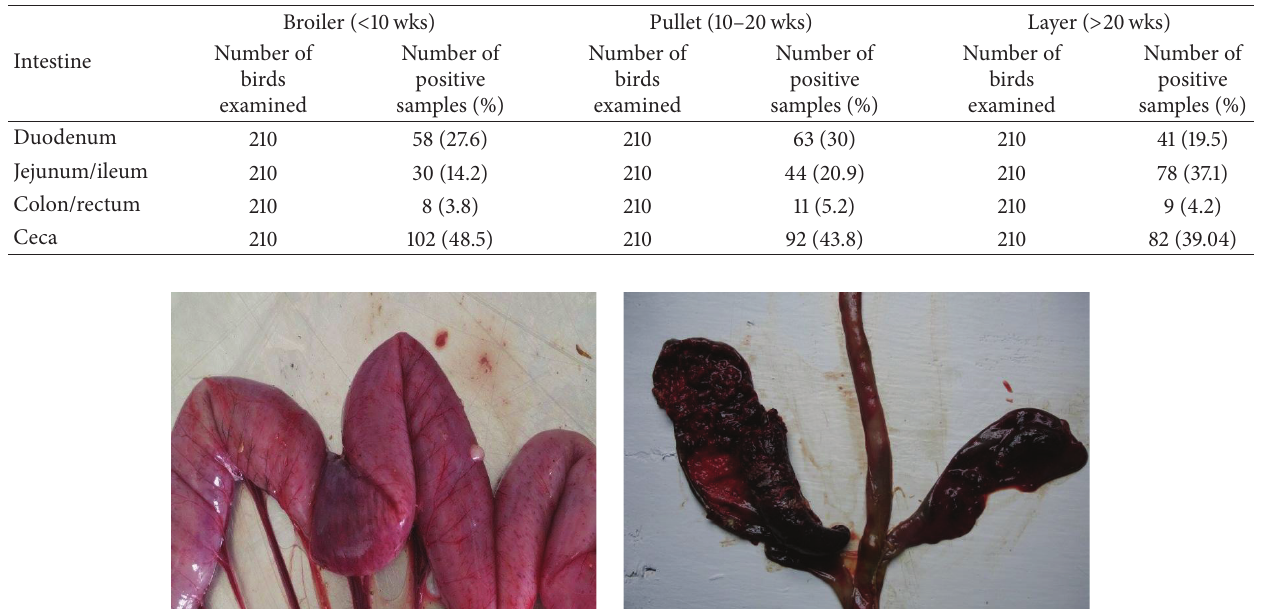
Table 5: Gross lesions attributed to different intestinal segments of infected birds in free-range chicken in Sidi Thabet, Tunisia.